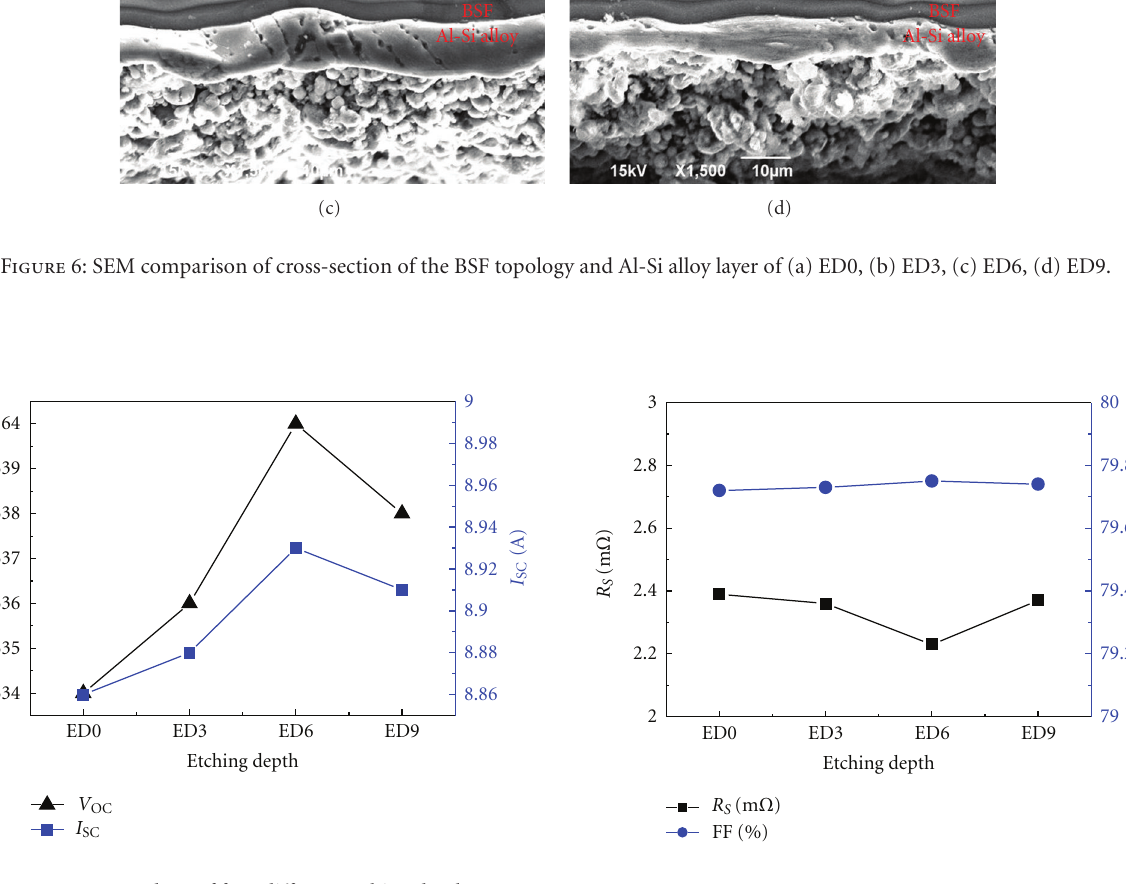
depths of 6 μ m ± 0.1 μ m and 9 μ m ± 0.1 μ m have better